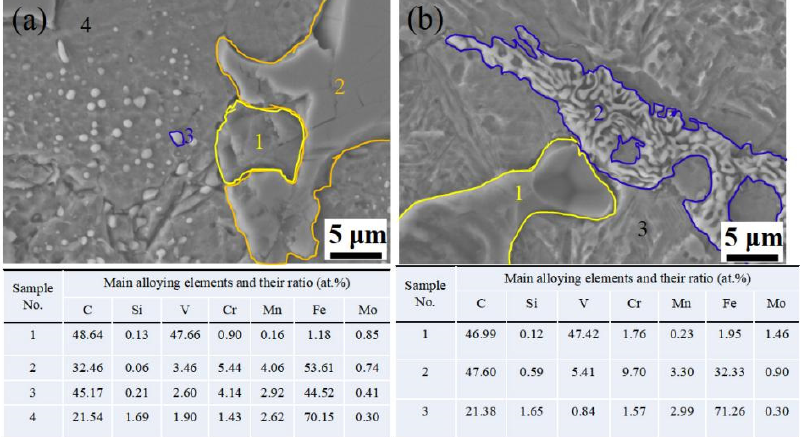
Figure 8. Typical microstructures and their elements ratio under different heat treatment pro- cesses. ( a ) QPT; ( b ) MQPT. ( a ) QPT; ( b )